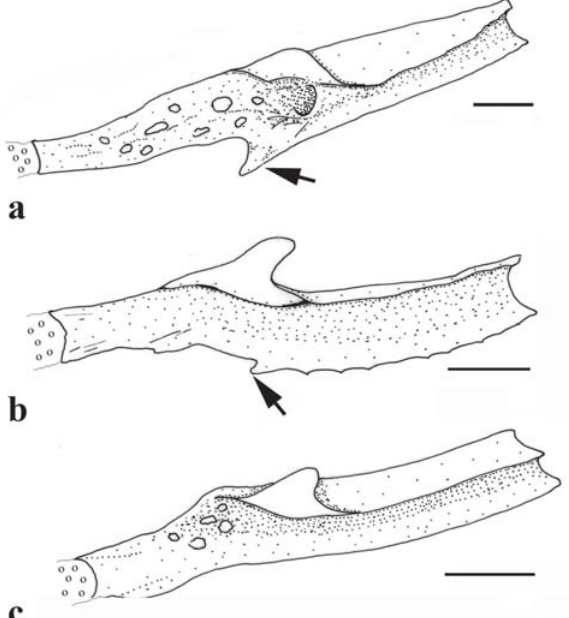
Fig. 26. Dorsal view of first epibranchial (right side) of Lamontichthys filamentosus (LACM 41741-9, 119.4 mm SL) (a), Pterosturisoma microps (MZUSP 79909, 75.9 mm SL) (b), and Harttia loricariformis (MZUSP 66187, 67.7 mm SL) (c). Arrow points to posterior process of first epibranchial. Scale bar = 1 mm.